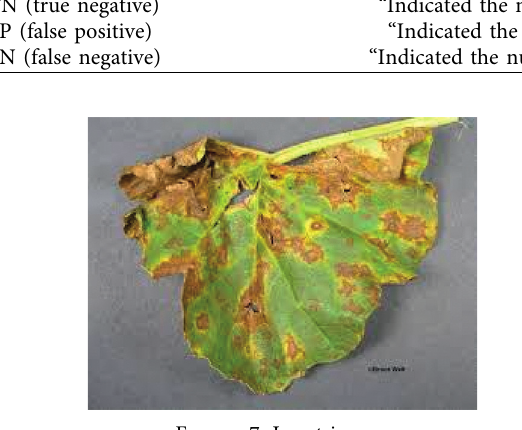
Figure 11: Objects in cluster 3.